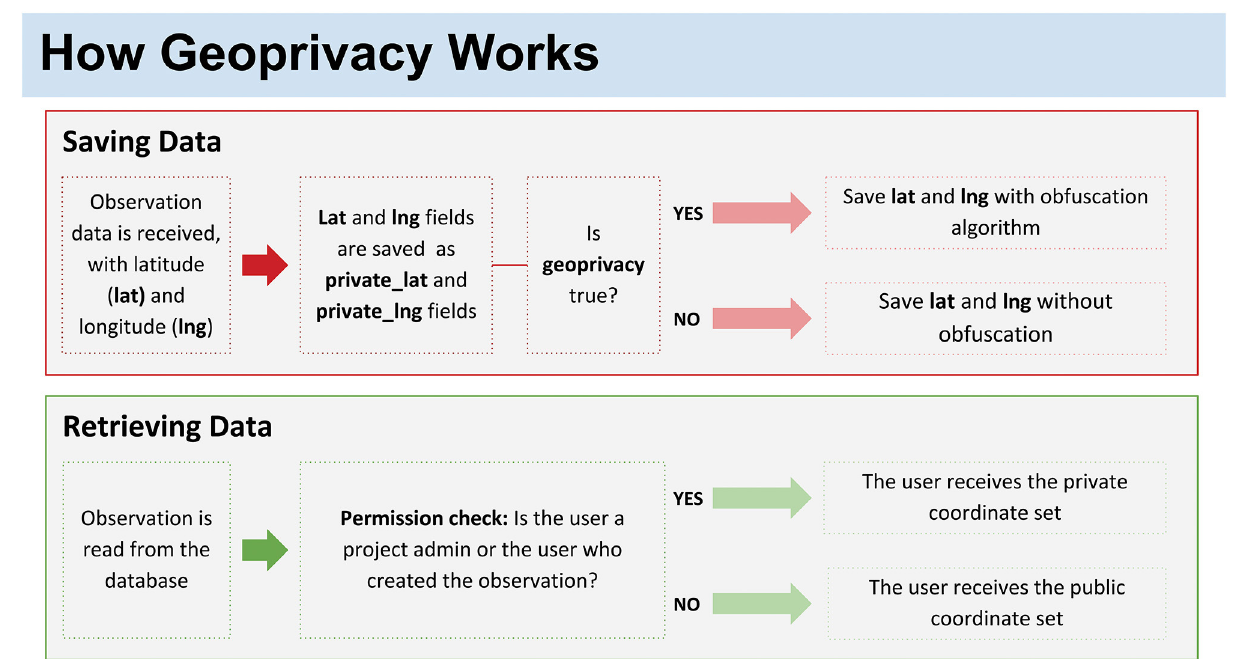
FIGURE 4 | How geoprivacy works. When geoprivacy is needed for a project, the lat and lng are saved with an obfuscation algorithm. When data are retrieved with geoprivacy options in place, there is a permission check to ensure that privacy is maintained.